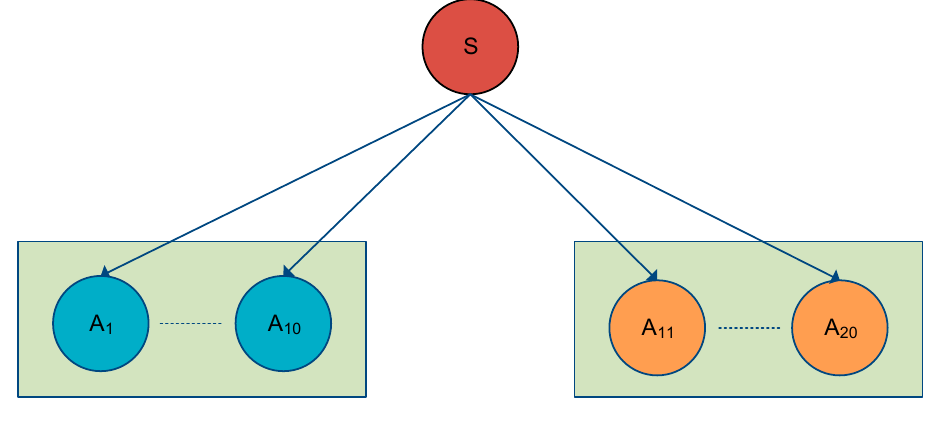
Figure 17. Bayesian network information fusion for MPPT.